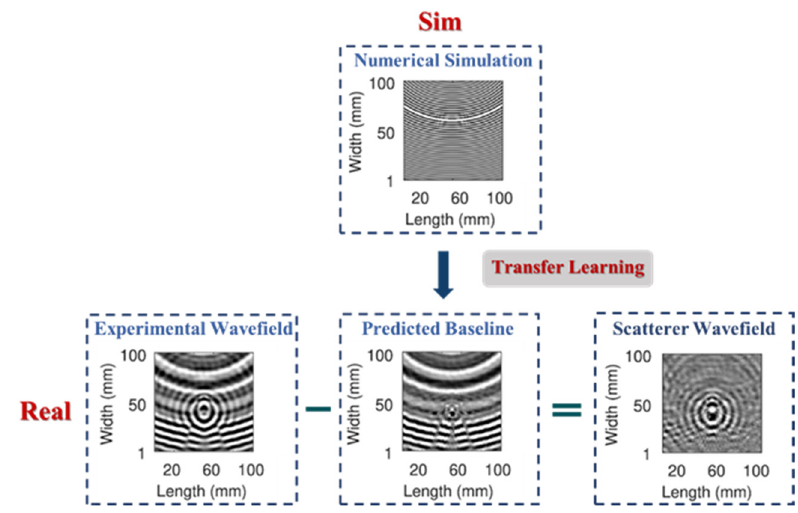
Figure 14. Wavefield prediction based on the “Sim-to-Real” approach [196] .